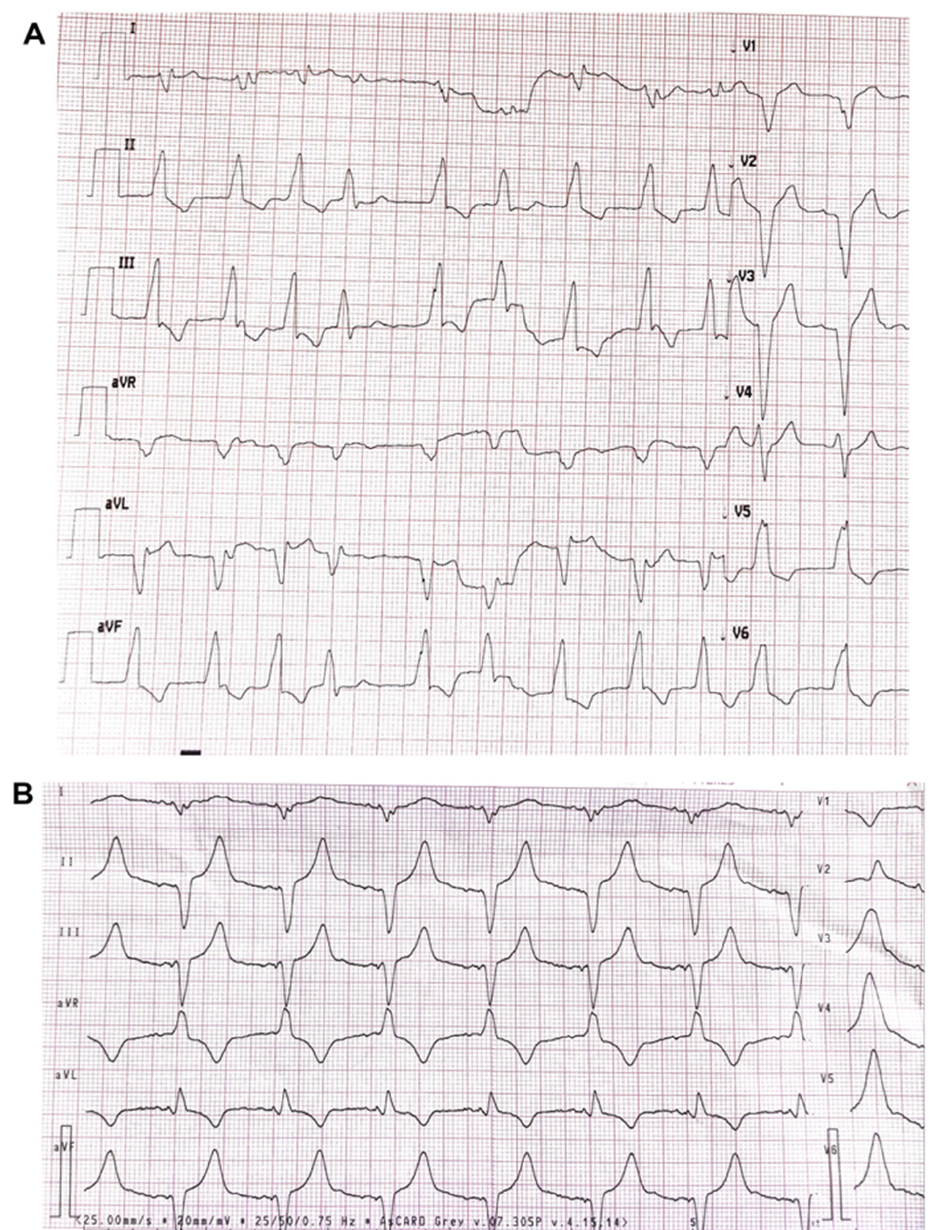
Figure 2. Patient ECG: ( A ) At admission to hospital on 3 March 2022. AF with average ventricular rate 112 bpm, LBBB, QRS width 170 ms. ( B ) At discharge from hospital on 5 March 2022. Atrial and biventricular pacing at 65 bpm.